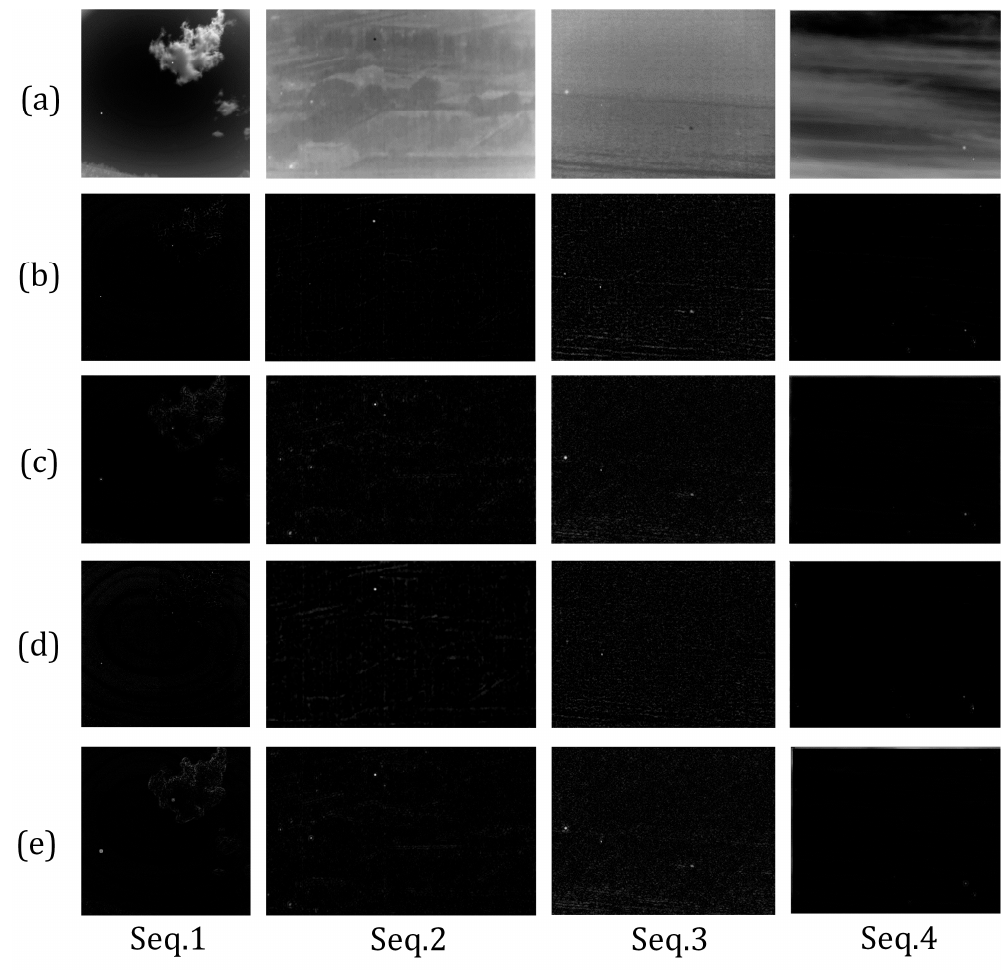
Table 2. Statistical results of η (%) for the in-frame detection.